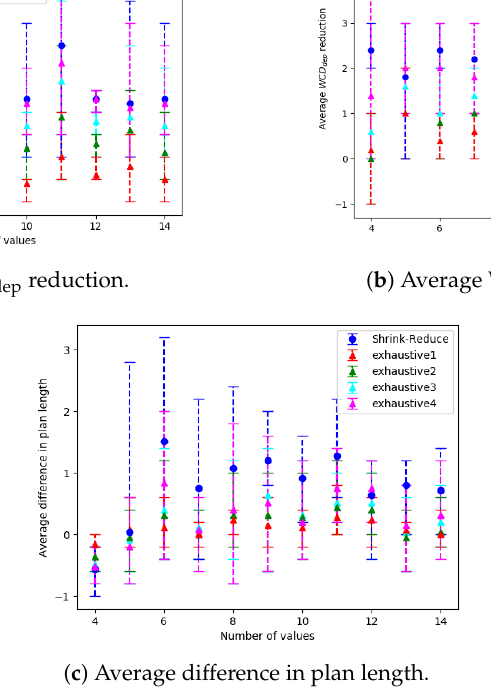
Figure A2. Results for an increasing number of